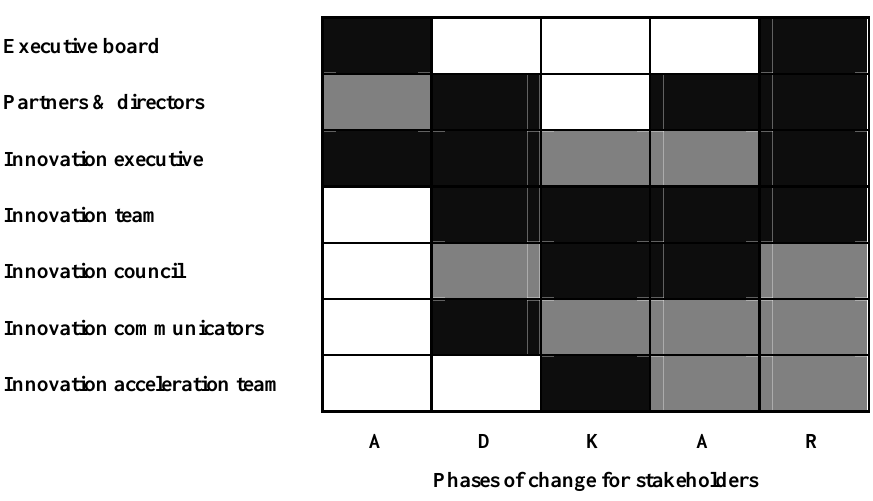
Fig. 5. Involvement of the firm ’s partners and innovation